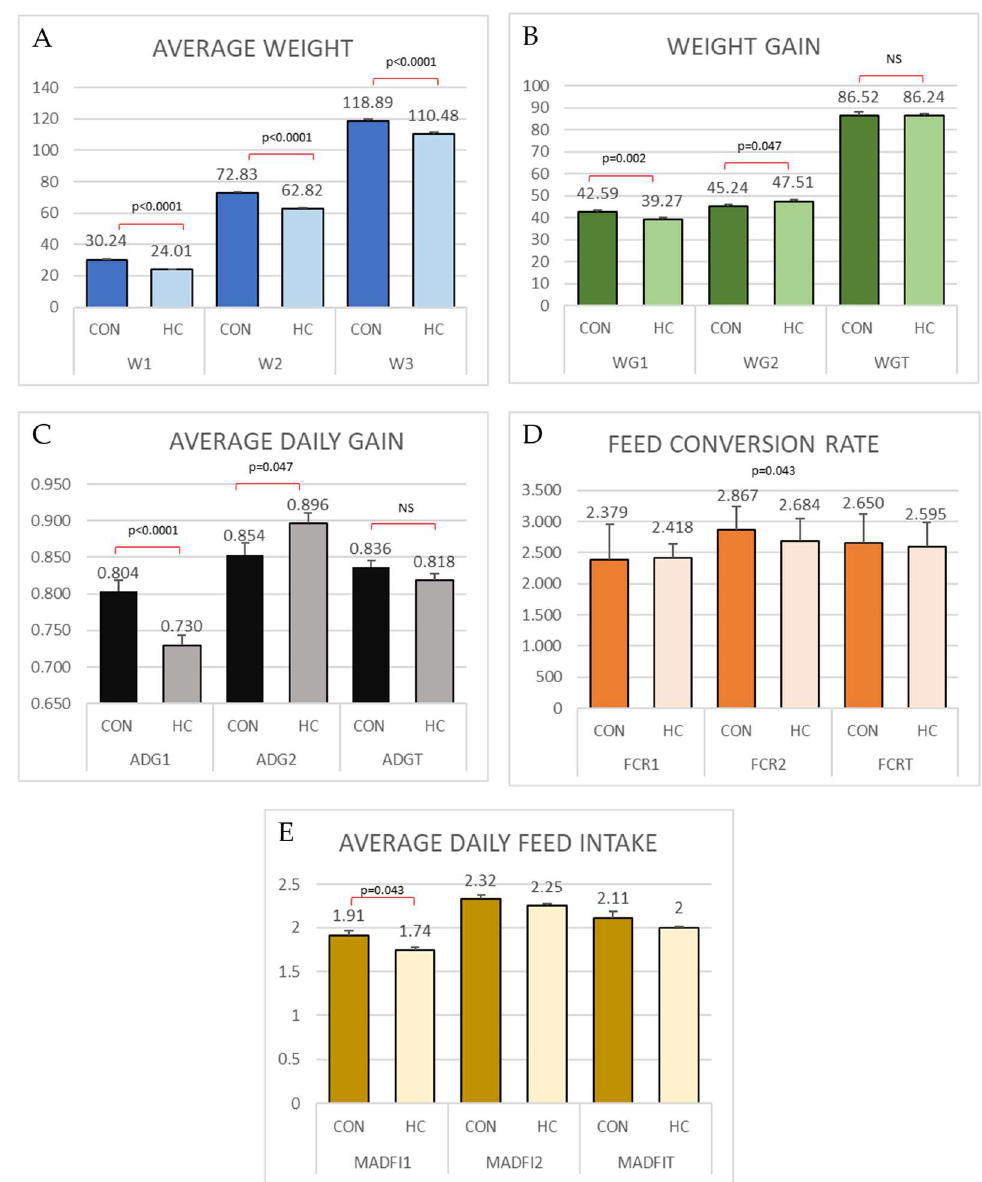
Figure 2. Physical performances. ( A ) Weight (mean ± SEM) at each weighting point, ( B ) Weight gain in growing (WG1), finishing (WG2) and the whole period (WGT). ( C ) Average daily gain in growing (ADG1), finishing (ADG2) and the whole period (ADGT), ( D ) Feed Conversion Rate in growing (FCR1), finishing (FCR2) and the whole period (FCRT), and ( E ) Average Daily Feed Intake in growing (ADFI1), finishing (ADFI2) and the whole period (ADFIT) on individual basis. The bars represent Mean ± SEM. The p -value is indicated in those parameters that showed significant differences.